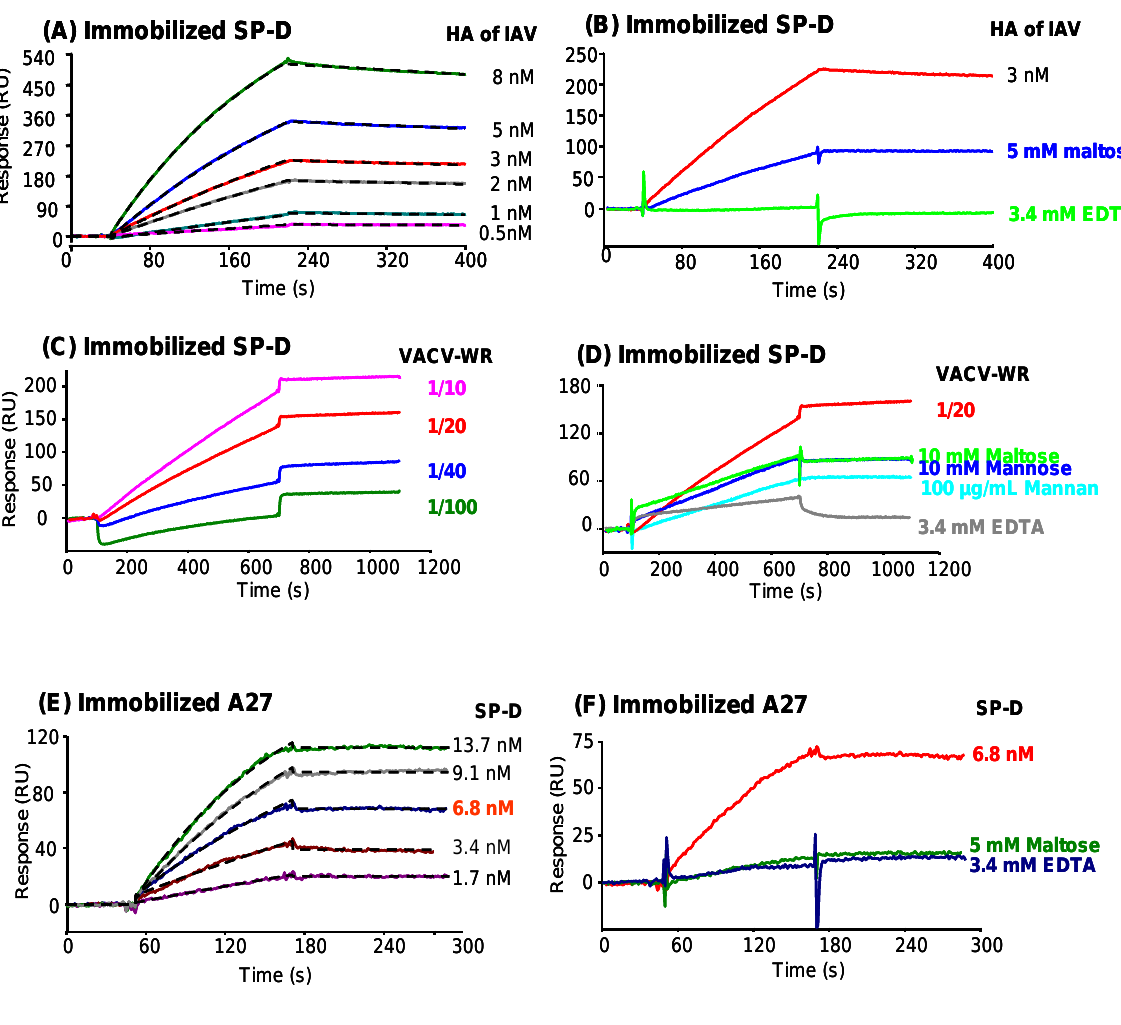
Figure 5. SPR analysis of the interaction of VACV with immobilized SP-D. VACV-WR particle binding to SP-D: (A) SPR analysis of the interaction of HA with immobilized SP- D. HA of IAV was injected at concentrations of 0.5, 1, 2, 3, 5 and 8 nM over immobilized SP-D. (B) HA (3 nM) was injected over immobilized SP-D in the presence of selected competitors of SP-D-ligand interaction (5 mM maltose or 3.4 mM EDTA). (C) iVACV was injected at various concentrations ranging from equivalent titer 2.10 8 to 2.10 9 virus/mL (corresponding to 1/100 to 1/10 dilutions, respectively) over immobilized SP-D. (D) iVACV (1/20 dilution) was injected over immobilized SP-D in the presence of competitors of SP-D interaction with carbohydrates (10 mM maltose, 10 mM mannose, 100 µg/mL mannan or 3.4 mM EDTA). All results are representative of two independent experiments. Sensorgrams were distorted at the beginning and end of injections due to solvent effect. Binding of SP-D to viral A27 protein : (E) Purified SP-D was injected at concentrations of 1.7, 3.4, 6.8, 9.1 and 13.7 nM over immobilized A27. (F) SP-D (6.8 nM) was injected over immobilized A27 in the presence of 5 mM maltose or 3.4 mM EDTA. Results are representative of two independent